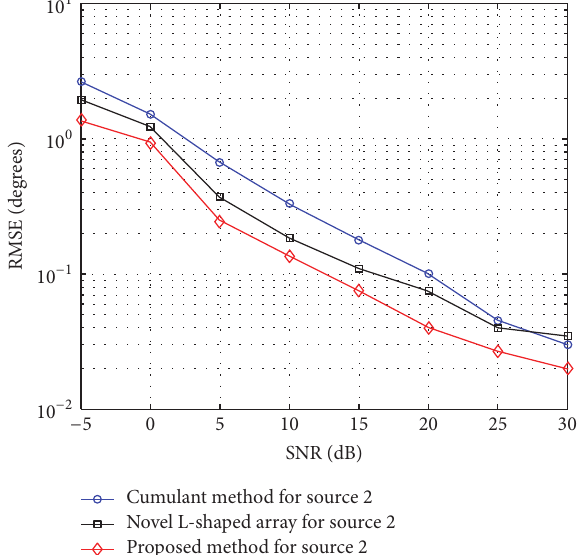
Figure 3: Comparison of RMSE of joint azimuth-elevation versus SNR for source 2 located at (80 ∘ ,70 ∘ ) using proposed method, novel L-shaped, and cumulant method.